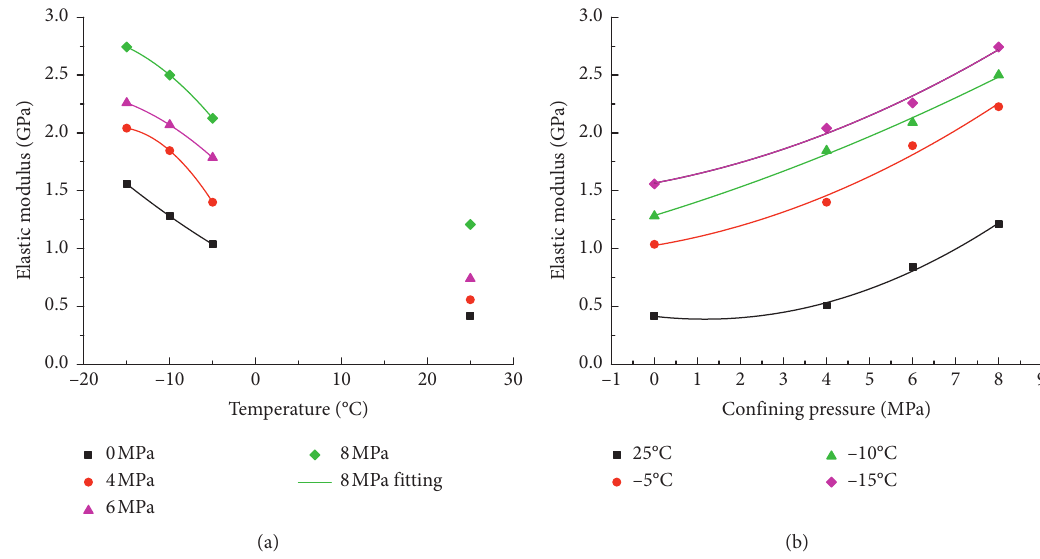
Figure 8: Elastic modulus curves under different conditions: (a) temperature and (b) confining pressure.